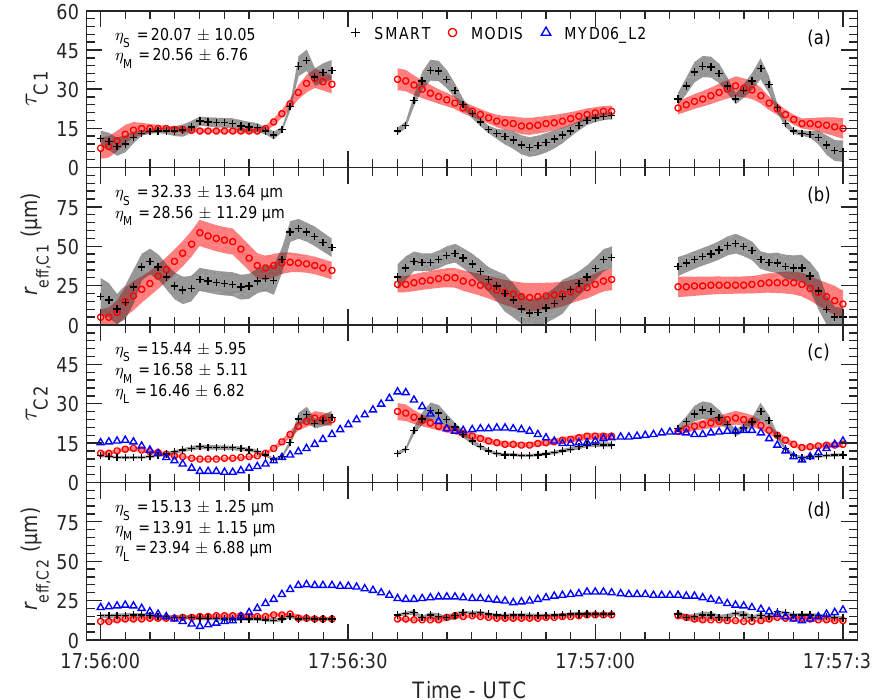
Figure 14. Same as Fig. 13 but for the DCC